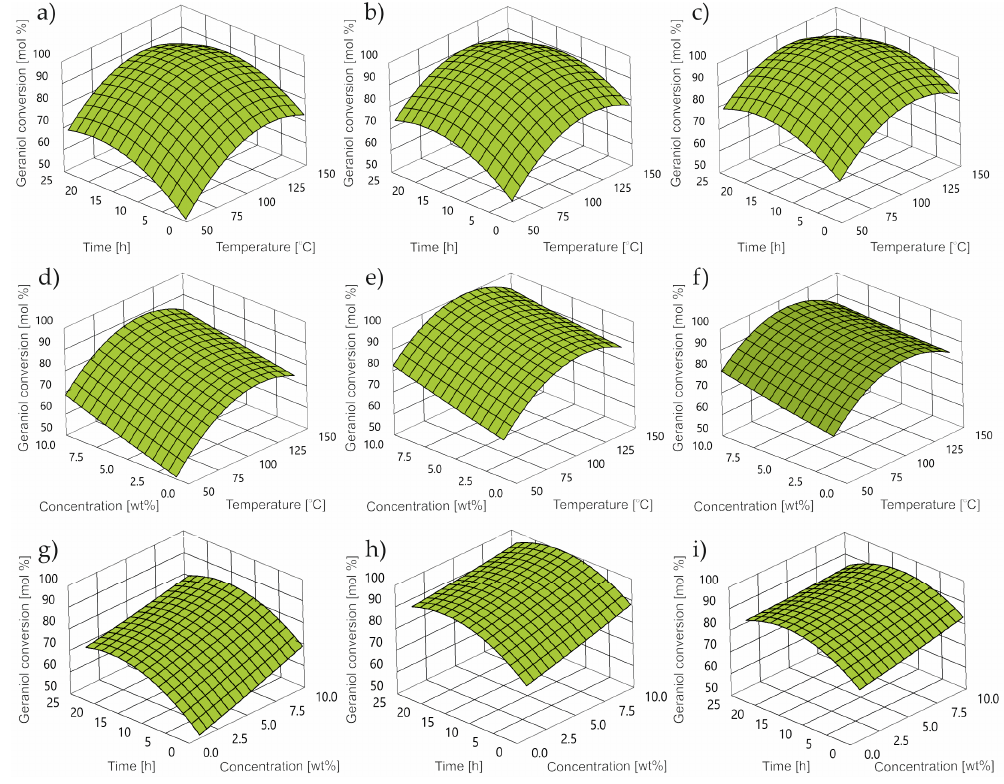
Figure 4. Contour plot of GA conversion at: concentration ( a ) 1 wt%; ( b ) 5 wt%; ( c ) 10 wt%; reaction